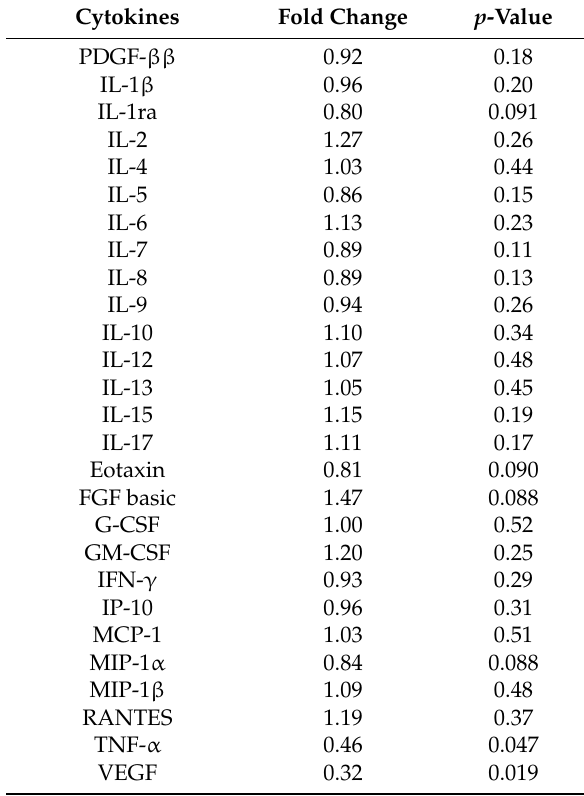
Table 4. Comparison between the fluorescence intensities (FI) evaluated in treated and untreated cells for the 27 cytokines in terms of fold changes and p